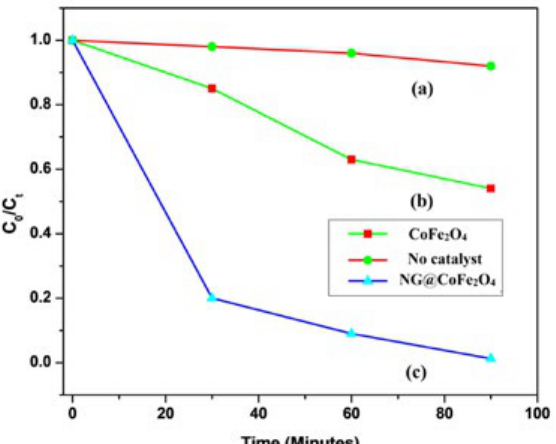
Fig. 10: Kinetics of photodegradation of methylene blue (a) no catalyst (b) CoFe